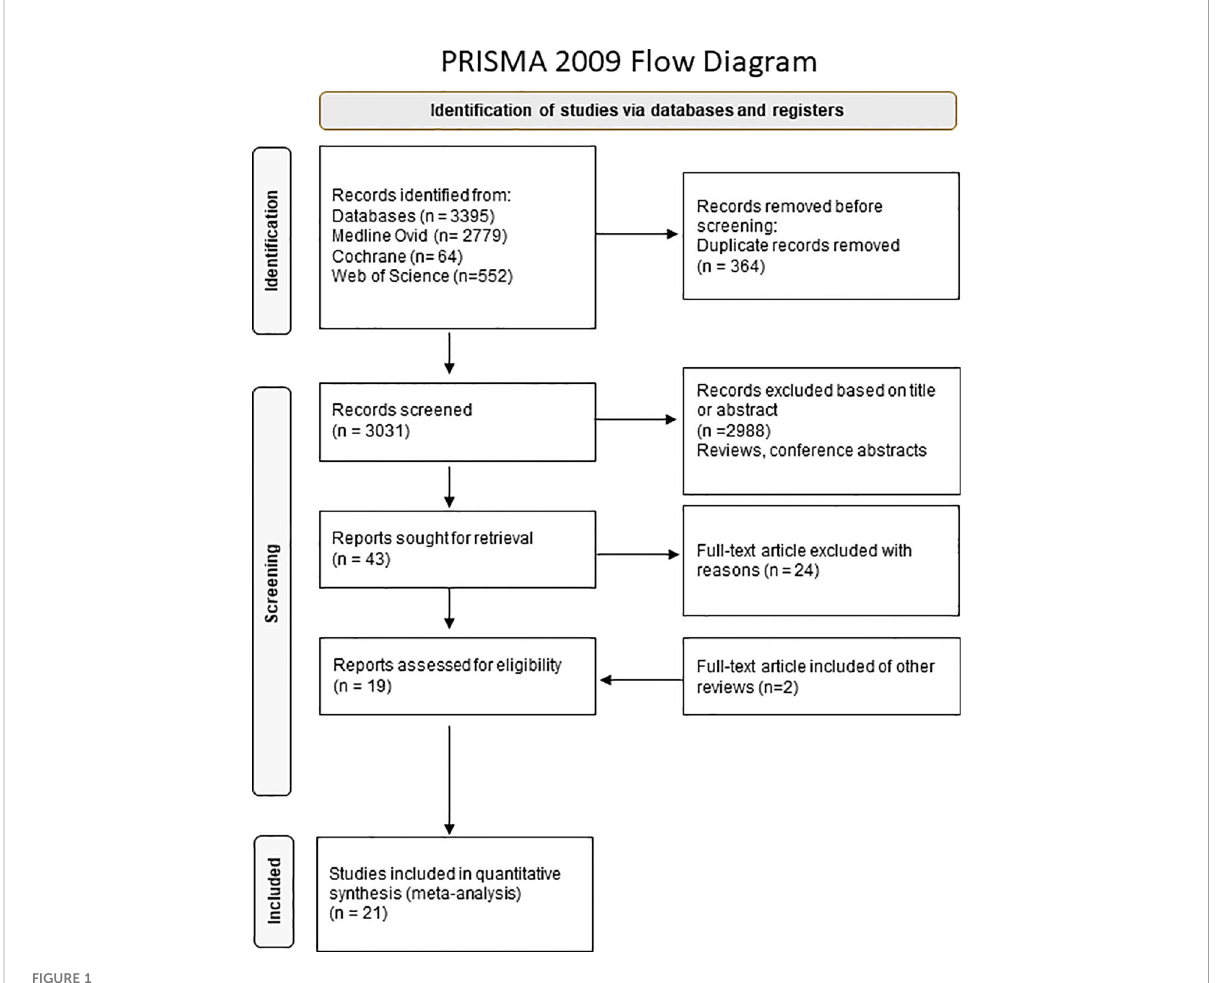
FIGURE 1 Flowchart of literature